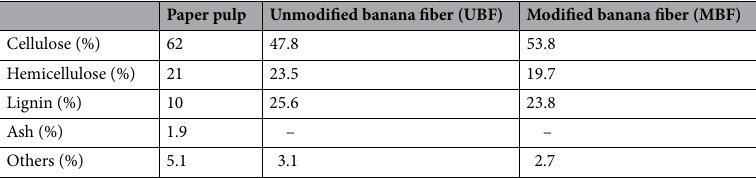
Table 4. Chemical compounds present in waste paper, untreated and treated banana